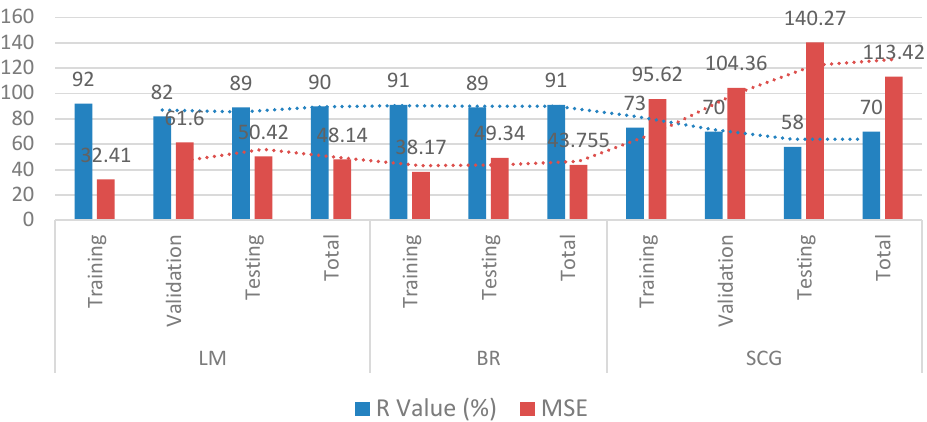
Figure 21. R-value (in % age) and MSE of LM, BR, and SCG algorithms.